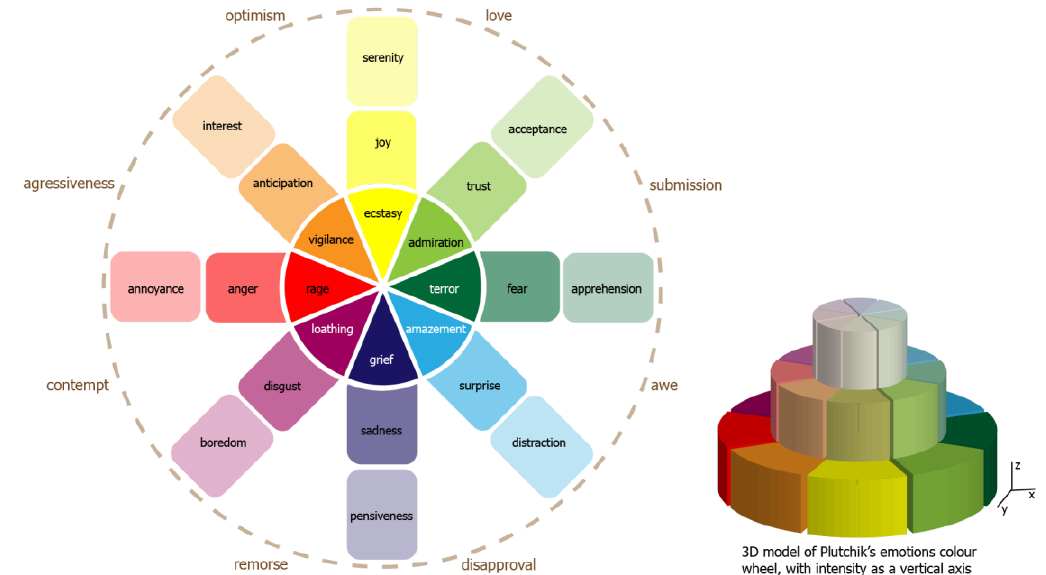
Figure 1 | Plutchik’s emotion colour wheel. If the outer flaps are bent toward the centre, its shape resembles that of a cone, with intensity as its vertical axis. The top tier is smaller since intensity is at its lowest, making all the emotions very close/similar. Source: